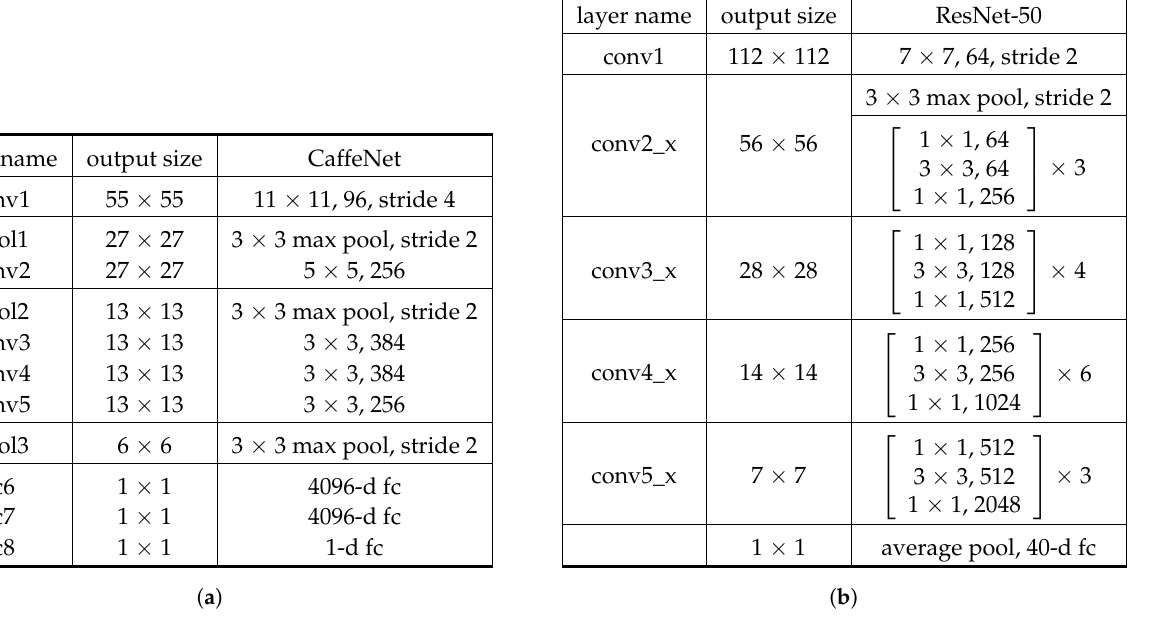
Figure 3. The CNN architectures of the feature extractors. ( a ) CaffeNet architecture used for DeepIA [7] and DeepBIQ [26]. ( b ) ResNet-50 architecture used in Alignment-Free Facial Attribute Classification Technique (AFFACT)